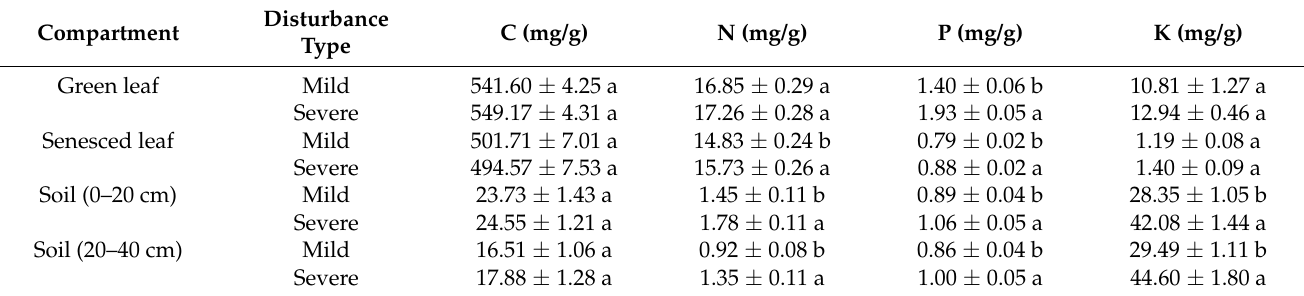
Table 1. The contents (mean ± standard error (SE)) of the organic carbon (C), total nitrogen (N), total phosphorus (P), and total potassium (K) in green leaf, senesced leaf, and soil at 0–20 cm and 20–40 cm depths in the Phoebe bournei